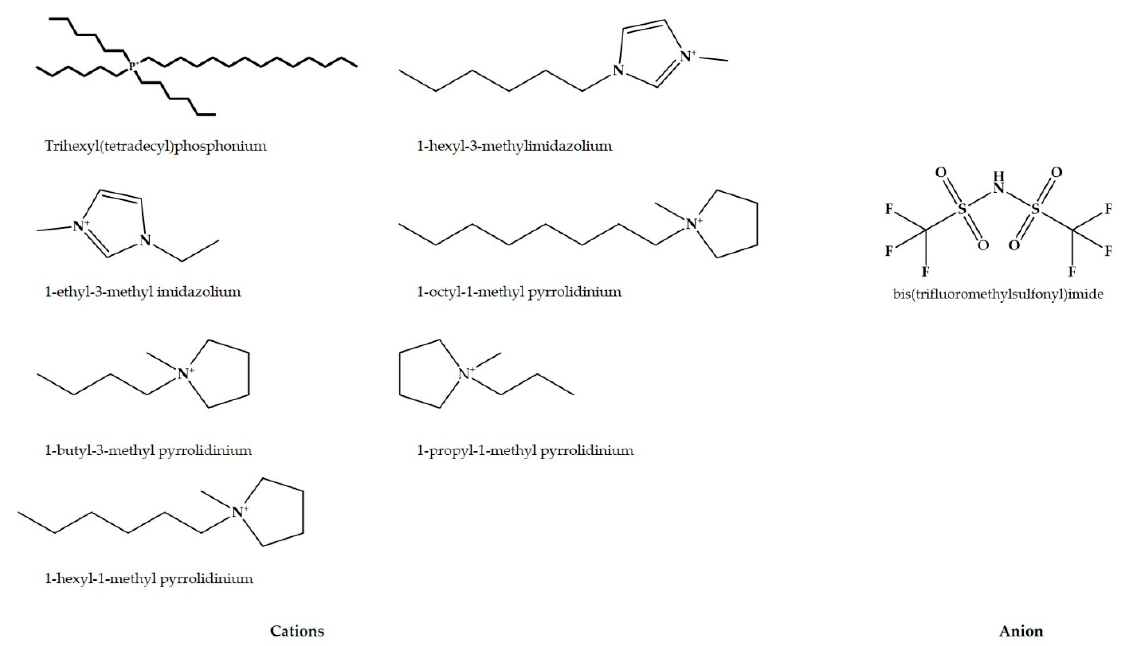
Figure 3. Schematic showing the structure of commonly used cations and a common anion [Tf 2 N] − for preparing the air and water-stable ILs.